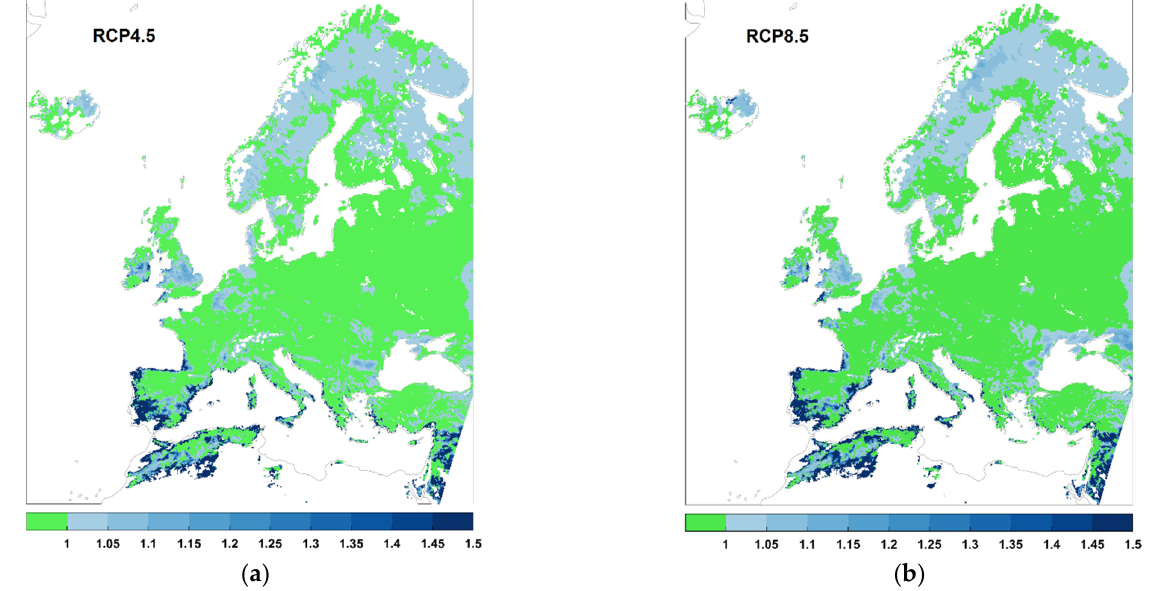
Figure 7. FC envelope maps for characteristic ground snow loads according to the RCP4.5 ( a ) and RCP8.5 ( b ). For each cell of the EUR-11 domain, the maximum value of FC in the moving time windows is shown.